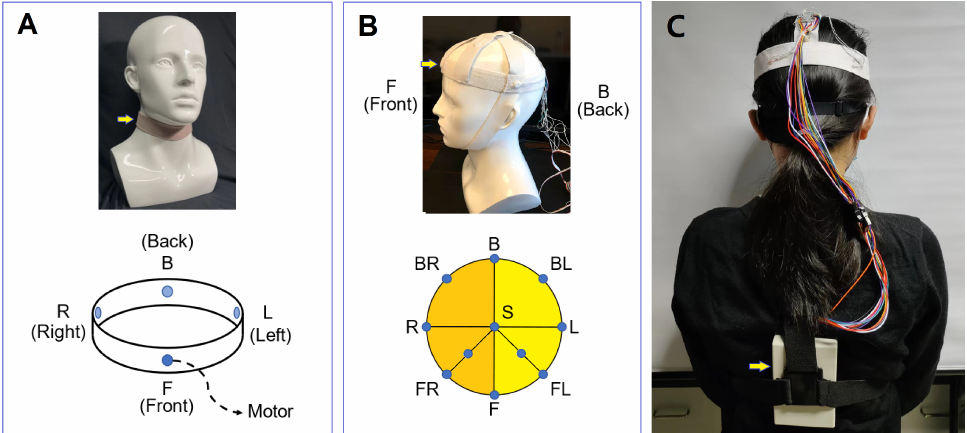
Figure 1. Schematic diagrams of the homemade tactile communication devices tested in this work. ( A ) A brown, ring-like neck device (highlighted by an arrow) was mounted on a gray 1:1 plastic head model. The neck device was embedded with four vibration motor actuators at the front, left, rear and right side of the user’s neck, which were denoted as F, L, B and R respectively. ( B ) A white head device mounted on a 1:1 white plastic head model. This head device was embedded with 11 vibration motor actuators located at the blue dot regions shown in the figure. For instance, the one mounted on the front position of the forehead was labeled as “F”. ( C ) A photograph of a tester wearing the 11-motor head device. The power circuit and wireless communication package were mounted on her